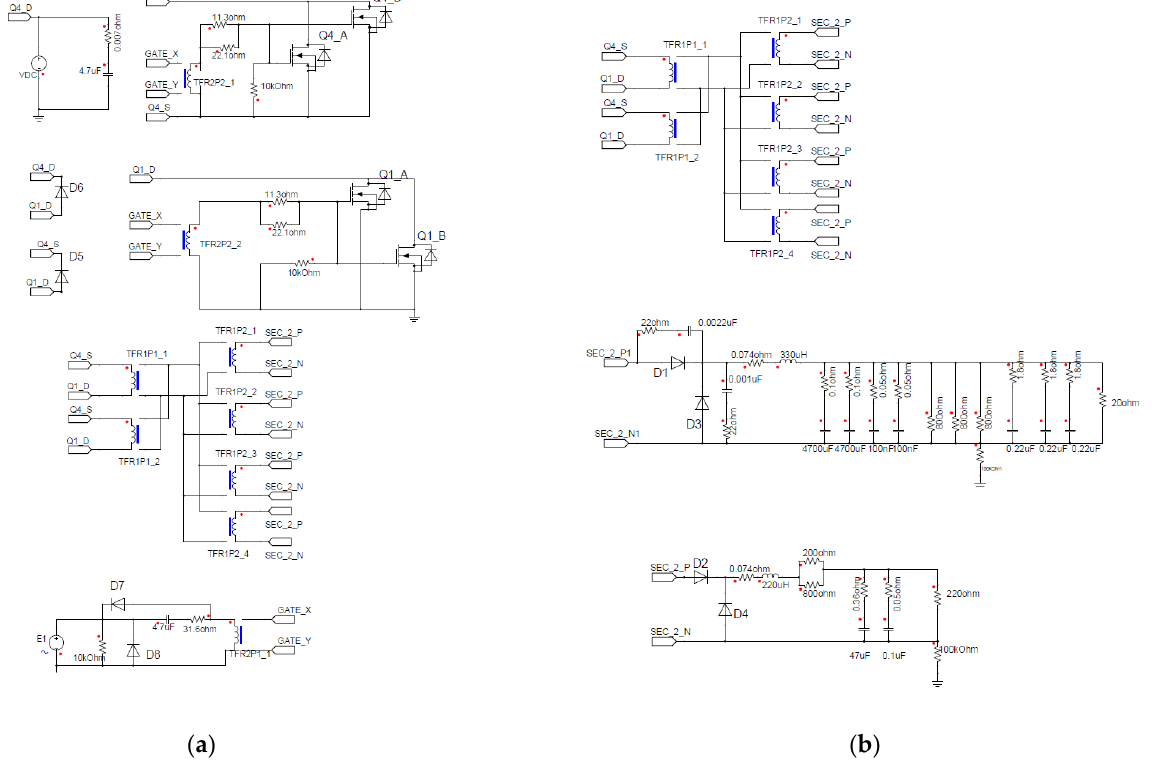
Figure 6. Electrical circuit of the two-switch forward converter: ( a ) primary side; ( b ) secondary